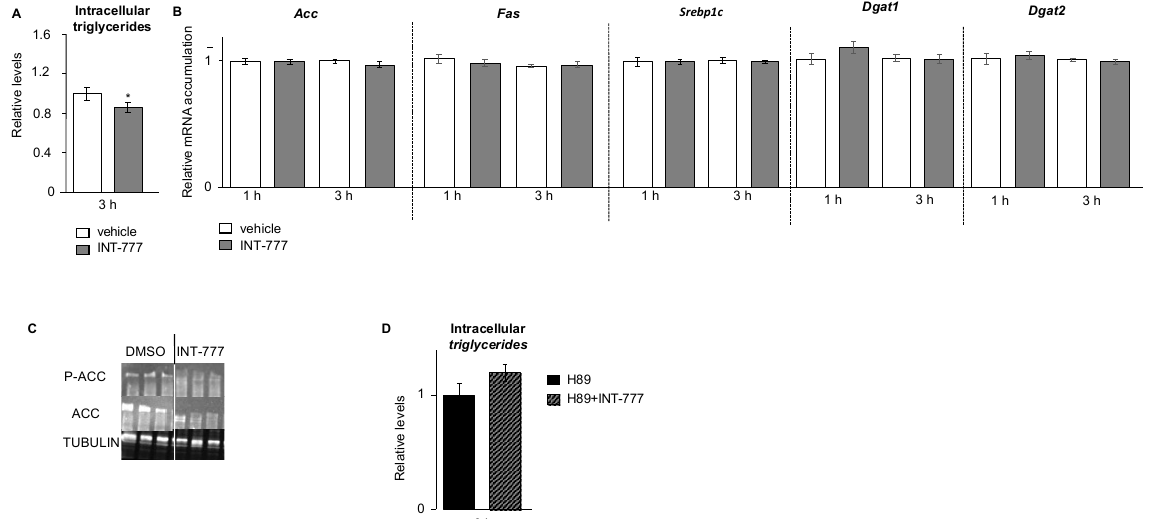
Figure 6. TGR5 modulated TG metabolism in a mouse Leydig cell line. ( A ) Relative intracellular levels of cholesterol in mLTC1 cells normalized to protein concentration 3 h after treatment with vehicle or INT-777. ( B ) Relative mRNA accumulations of Acc , Fas, Srepb1c , Dgat1, and Dgat2 normalized to β -actin in a mouse Leydig mLTC1 cell line treated with vehicle or hCG for 3 h. ( C ) Representative Western blots of P-ACC, ACC, and TUBULIN in mLTC1 cells treated with vehicle (DMSO) or INT-777 for 3 h. ( D ) Relative intracellular levels of cholesterol in mLTC1 cells normalized to protein concentration in cells pre-treated 2 h with H89 and then 3 h with vehicle or INT-777. In all panels, n = 9 to 12. Data are expressed as the means ± SEM. Statistical analysis: * p < 0.05. Even though there was a decrease in TG levels, a slight increase in lipid droplet size was observed in INT-777-treated cells (Figure 5), suggesting that there might be an accu- mulation of other lipid droplet components, such as cholesterol esters. We thus decided to analyze cholesterol levels, which is the initial substrate for steroidogenesis. The data show that the activation of TGR5 by the INT-777 led to an increase in total cellular choles- terol content (Figure 7A). This was not associated with the modulations of the mRNA accumulations of genes involved in their synthesis such as HmgcoA-reductase or HmgcoA- synthase (Figure 7B). The altered size of lipid droplets in INT-777-treated cells suggested that there may be an alteration in cholesterol storage. We analyzed the levels of cholesterol esters. The data show that this increase in cholesterol level corresponded to an increase in cholesterol ester levels (Figure 7A). These data suggest that there might be an increased storage or an alteration of the hydrolysis of cholesteryl esters stored in lipid droplets, which could explain both high cholesterol contain and lower testosterone production. For that, we analyzed by RT-qPCR the mRNA accumulation of the hormone-sensitive lipase ( Hsl ) that is responsible for neutral cholesteryl ester hydrolase activity. No modulation of the mRNA accumulation of Hsl was observed in response to INT-777 (Figure 7B). The effect of the INT-777 on cholesterol levels was abolished by pre-treatment with H89 (Fig- ure 7C).